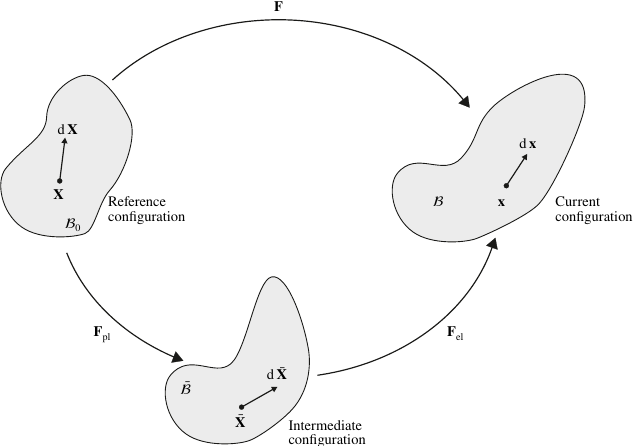
FIGURE4 Configurationdefinitionwithinthenonlinearcontinuummechanicframework. Figure 6. Configuration definition within the nonlinear continuum mechanics